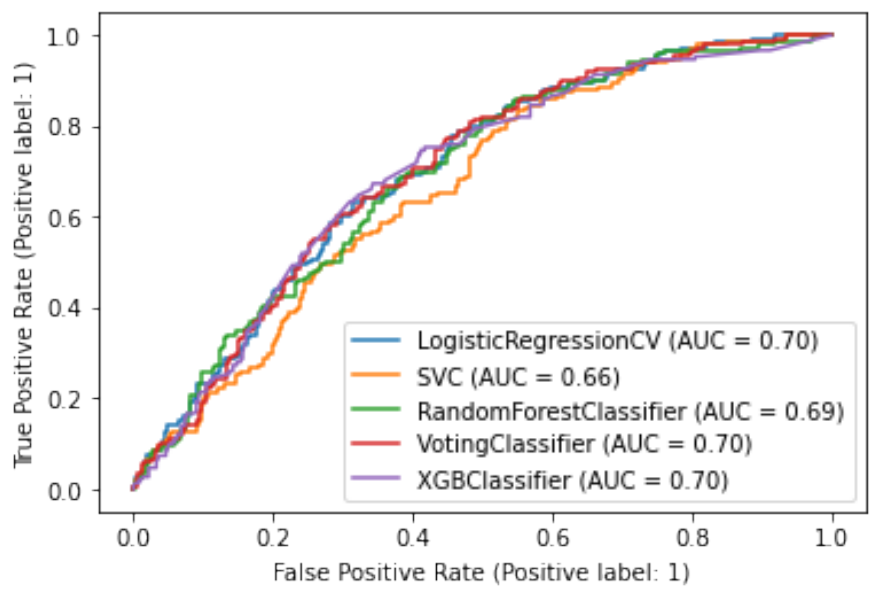
Figure 8. ROC curves of different models.